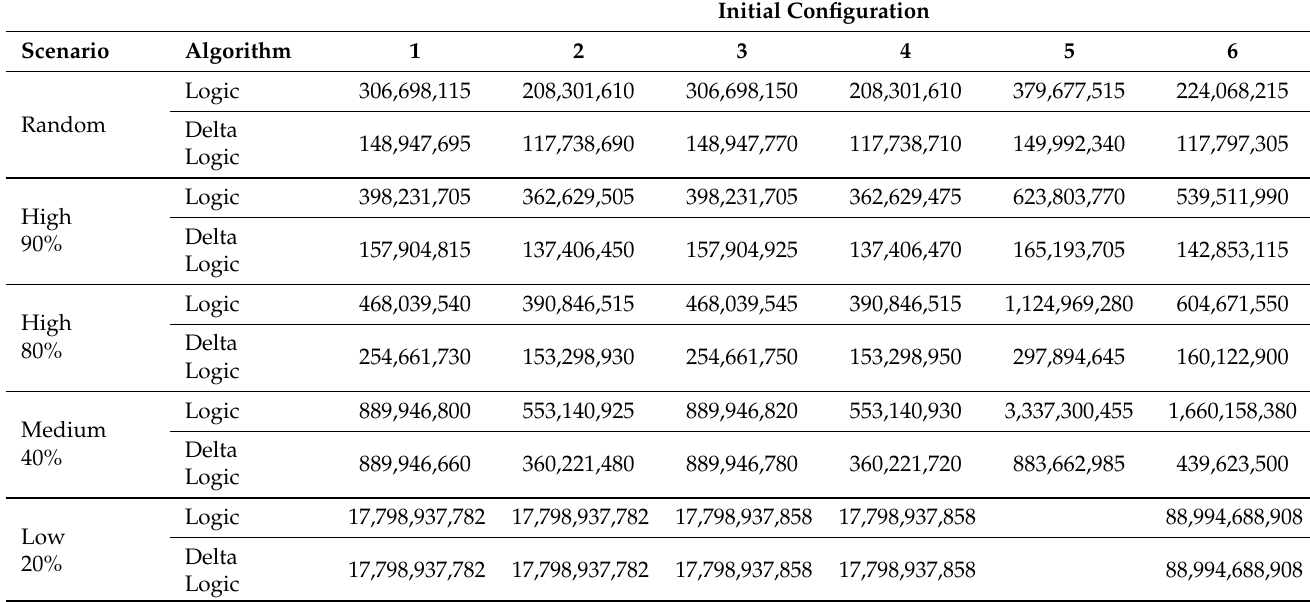
Table 6. Evaluation results (number of cycles that occurred in each test). Initial Configuration